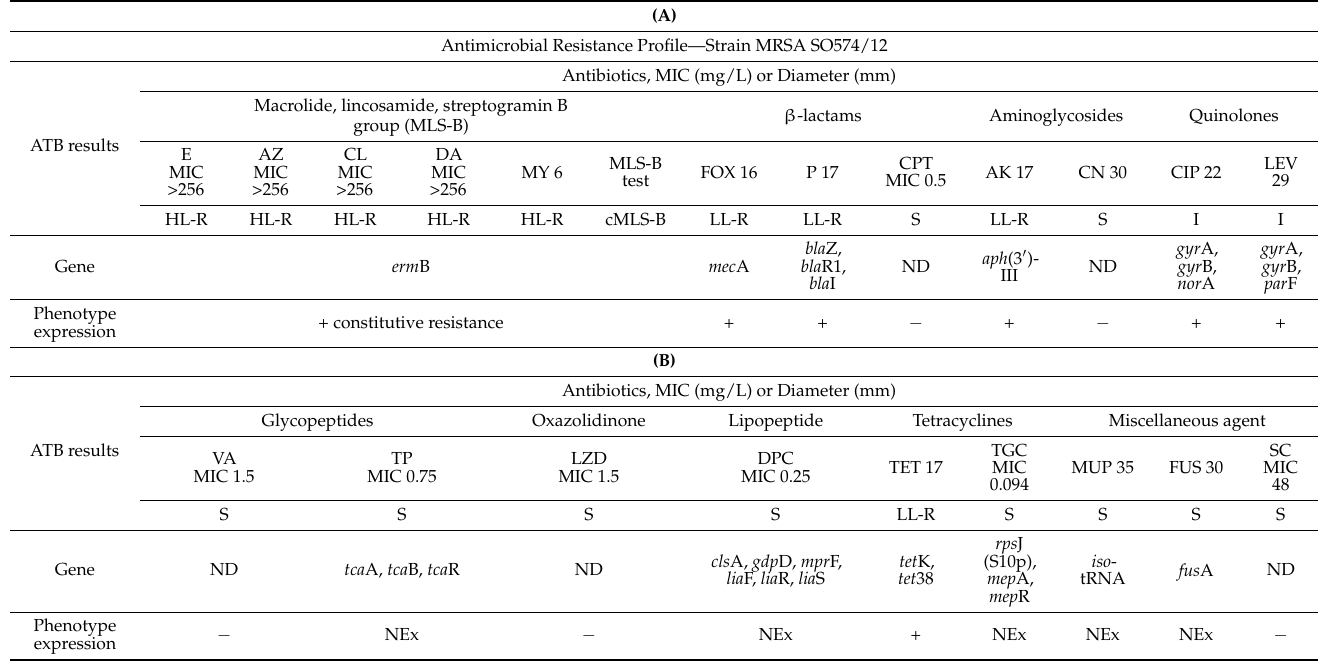
Table 2. ( A , B ) Antimicrobial resistance (AMR) profile of MRSA SO574/12 clinical isolate—phenotype with interpretation according to EUCAST guidelines [28] and correlation with AMR genomic- based data.